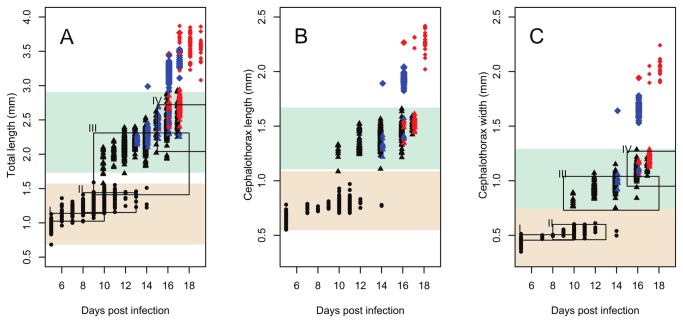
Increase in size of

L

. salmonis
 larvae post infection.Total length (TL) measurements from both experiment 1 and 2 are shown in A. Cephalothorax length (CL) and cephalothorax width (CW) measurements from experiment 2 are shown in B-C. Samples assigned to the chalimus I/II category are shown as circles. Chalimus larvae assigned to the chalimus III/IV are shown as triangles. Preadult 1 are shown as diamonds. Post-incubation measurements are not shown except for preadult I females shown as small diamonds. Color codes: black=sex not determined, blue=male, red=female. Red shaded area= size range of cluster 1, blue shaded area=size range of cluster 2. Frames I-IV represent the sizes for the chalimus I-IV stages as reported by Schram [19] and durations as reported by Johnson and Albright [28] (chalimus IV duration extends to 21 DPI). Size and duration boxes are not shown for CL as no data were reported.